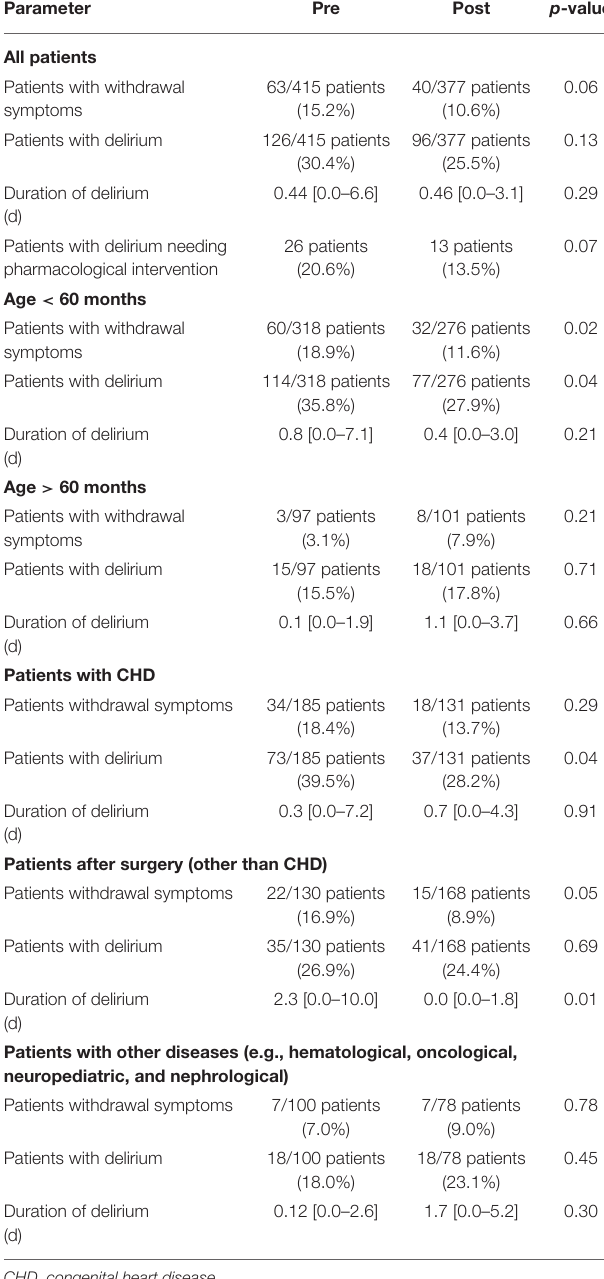
TABLE 1 | Differences of patients’ characteristics between the pre-implementation group and post-implementation group. Parameter